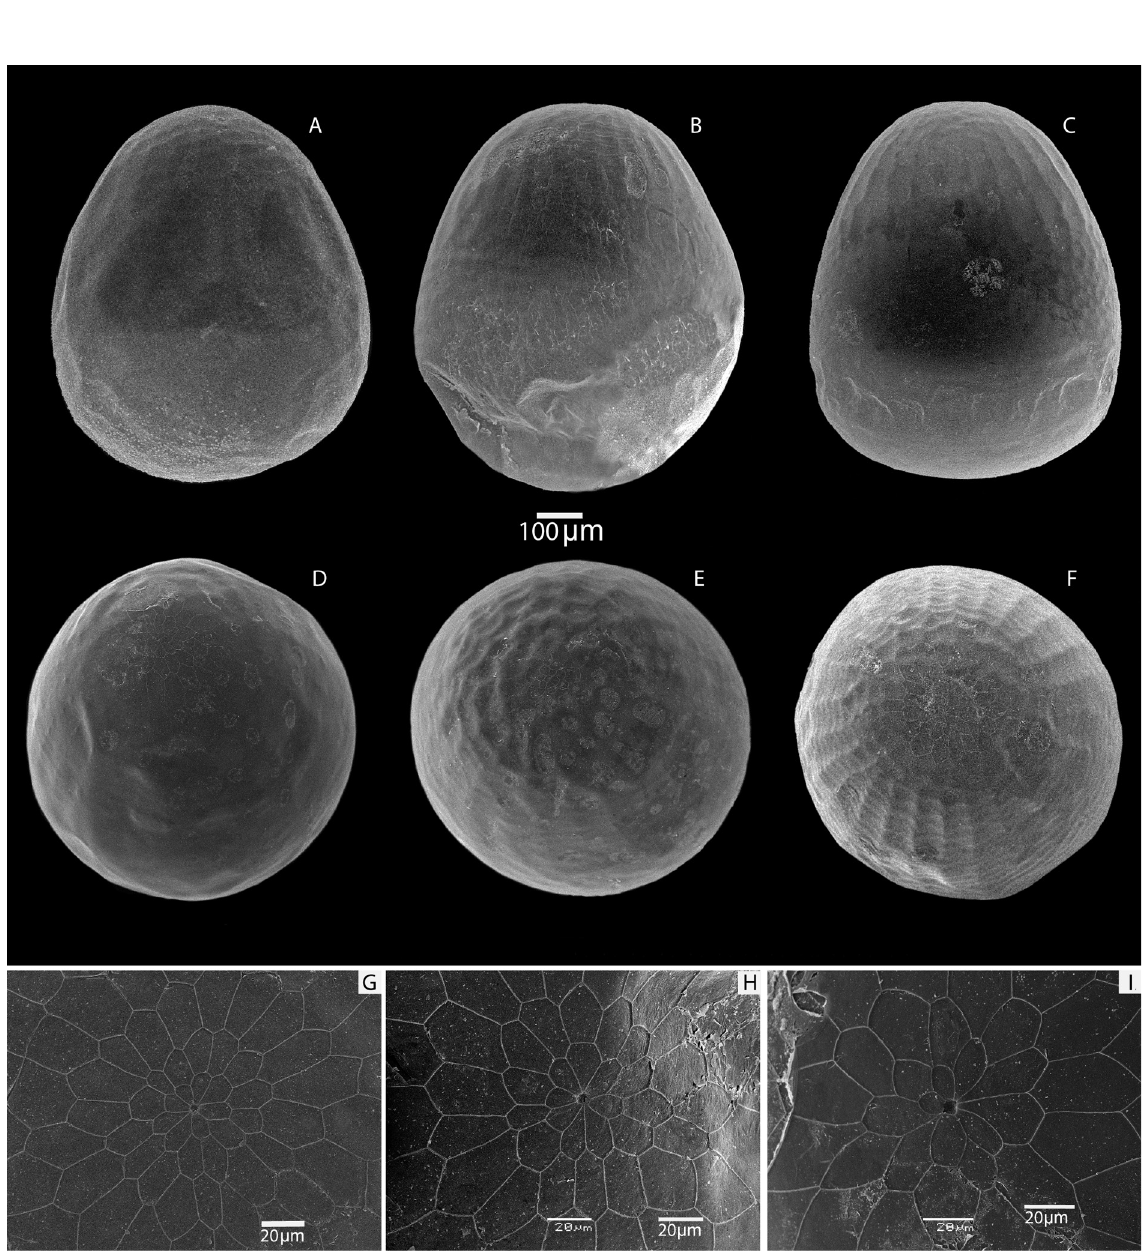
Fig. 23. Eggs of Melitaea shahvarica sp. nov., Iran, Semnan Prov., Shahrud area, S macroslope of Shahvar Mts, alt. 2200–2400 m. A–C . Lateral view. D–F . View from above. G–I . Micropile